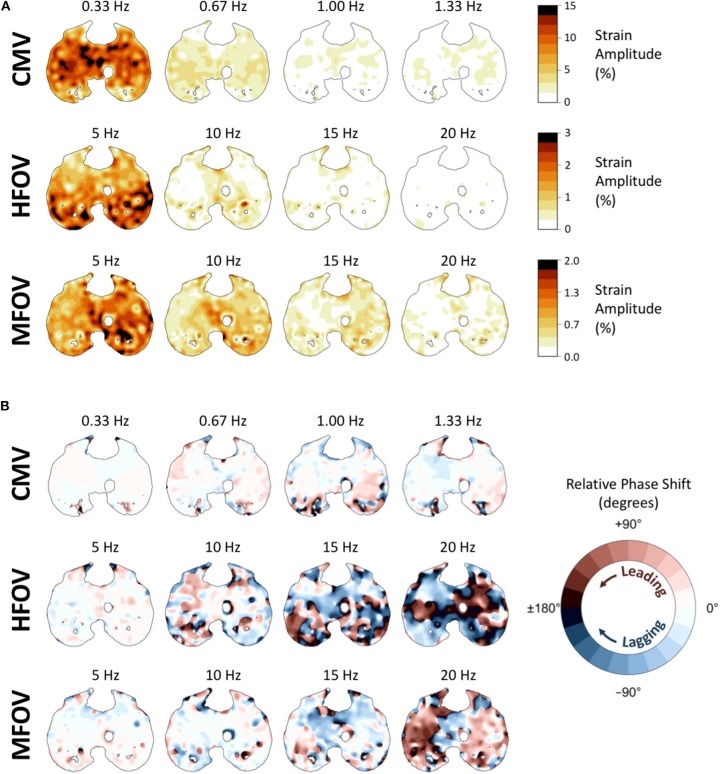
Frequency-domain representations of tissue-correlated regional strain amplitude (A) and phase variations (B) in one subject during conventional mechanical ventilation (CMV), high-frequency oscillatory ventilation (HFOV), and multi-frequency oscillatory ventilation (MFOV). For each ventilation modality, strain amplitudes and phases were obtained from the discrete Fourier transform of time-varying Jacobian determinants within each voxel, using transformations mapped to a single reference image. In each cross-section of the reference image, voxel color in (A) indicates the strain amplitude at that frequency, corresponding to the amplitude of volumetric strain relative to the minimum volume of that particular voxel. Voxel color in (B) indicates the amount of phase shift (leading or lagging) relative to the median phase of all lung voxels at the specified frequency.